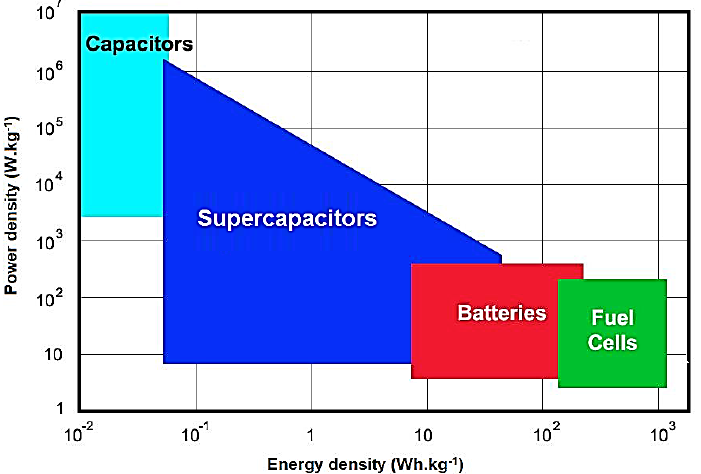
Figure 1. Ragone chart of power density vs. energy density for various energy devices [23]. Repro- duced with permission from Elsevier.